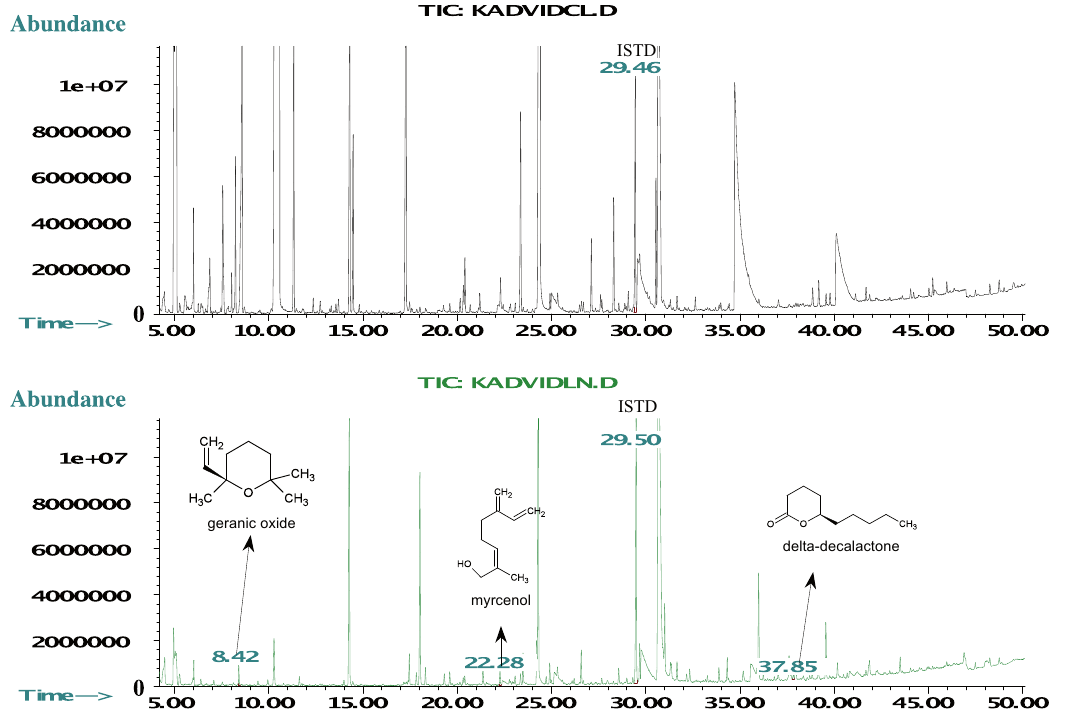
Fig. 1: The TICs of the Szekszárdi Kadarka wine samples, simple distillation followed by LLE extraction (upper), LN-SDE extract